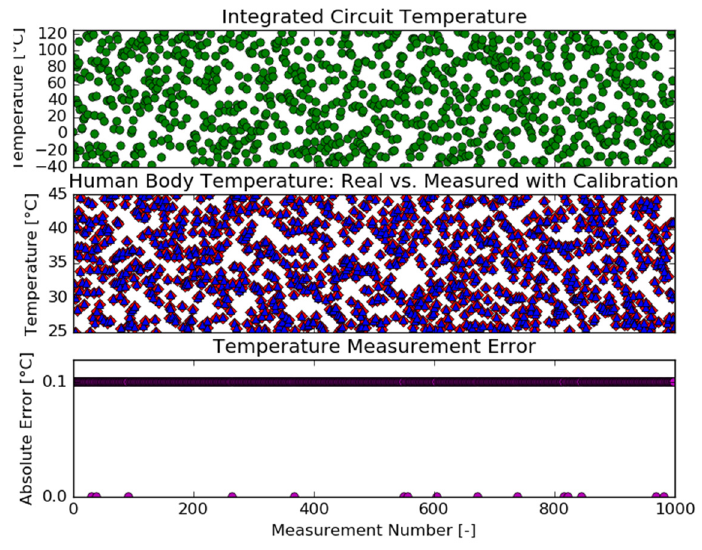
Figure 19. Monte Carlo simulations with temperature calibration technique.